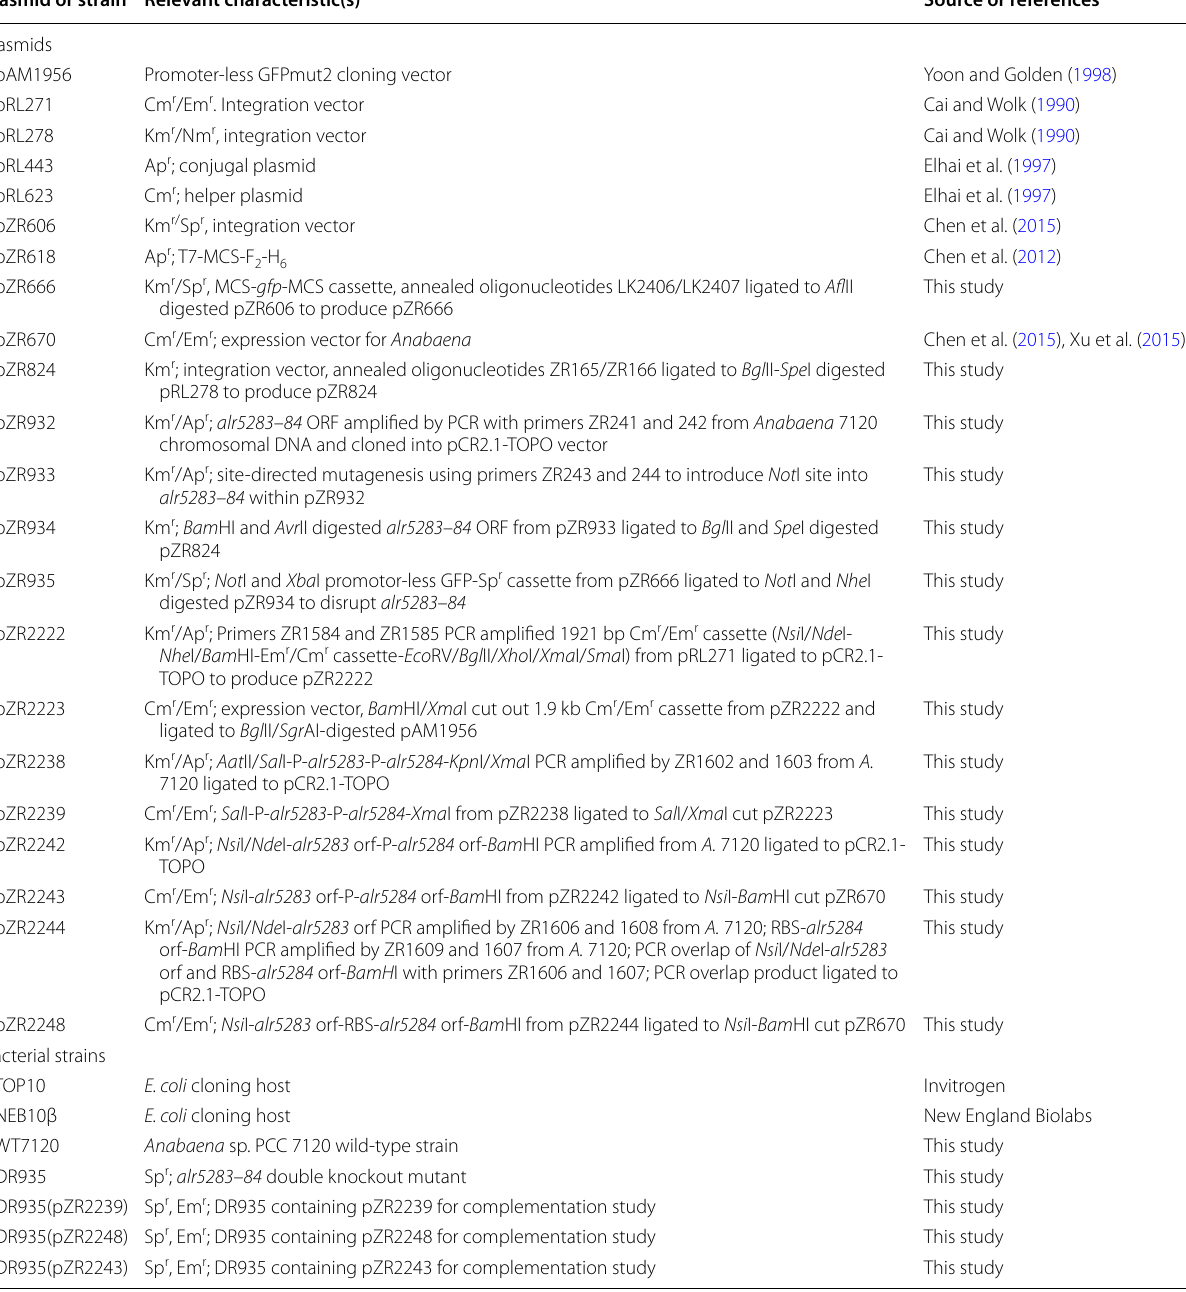
Ap r : ampicillin resistance; Sp r : spectinomycin resistance; Nm r /Km r : neomycin–kanamycin resistance; Cm r /Em r : chloramphenicol–erythromycin resistance; F 2 : two FLAG epitopes; MCS: multiple cloning sites; RBS: ribosome-binding site; P-: promoter; orf: open reading frame